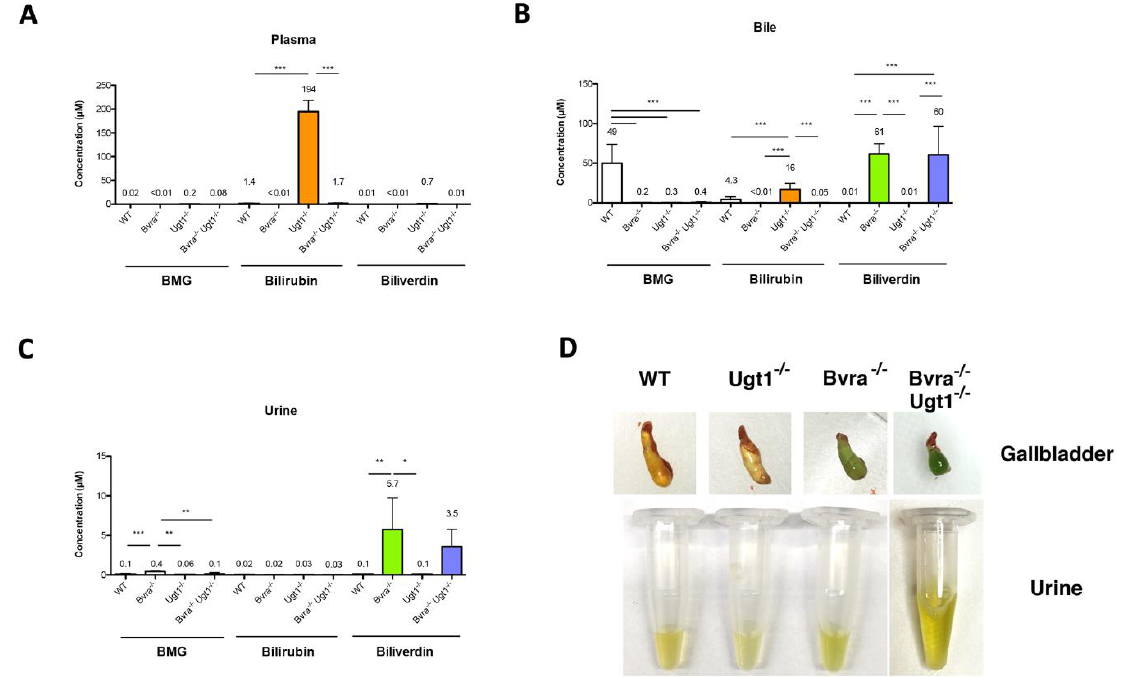
Figure 3. Bilirubin and biliverdin in plasma, bile, and urine. Bilirubin monoglucuronide (BMG), bilirubin and biliverdin in plasma ( A ), gall bladder bile ( B ), and urine ( C ) in middle-aged (9-months-old) mice. Data represent the mean ± SD ( n = 5/gender/genotype; both genders are plotted together). The mean of each group is indicated above each respective bar. One-way ANOVA. Plasma: BMG, p ≤ 0.0001, F = 12.59; bilirubin, p ≤ 0.0001, F = 622.8; Biliverdin, p ≤ 0.0001, F = 86.22. WT vs. Bvra −/− Ugt1 −/− , ns (is indicated for BMG, bilirubin, and biliverdin). Bile: BMG, p ≤ 0.0001, F = 43.31; bilirubin, p ≤ 0.0001, F = 36.18; Biliverdin, p ≤ 0.0001, F = 32.00. WT vs. Bvra −/− Ugt1 −/− : p ≤ 0.001; ns; p ≤ 0.001 BMG, bilirubin, and biliverdin, respectively). Urine: BMG, p = 0.006, p = 10.10; bilirubin, p = 0.6433, F = 0.5662, ns; biliverdin, p = 0.0009, F = 9.260. WT vs. Bvra −/− Ugt1 −/− , ns (is indicated for BMG, bilirubin, and biliverdin). Bonferroni tests: *, p ≤ 0.05; **, p ≤ 0.01; ***, p ≤ 0.001. ( D ) Representative pictures of gallbladder (upper panels) and urine (lower panels) of WT, Bvra −/− , Ugt1 −/− and Bvra −/− Ugt1 −/− mice.